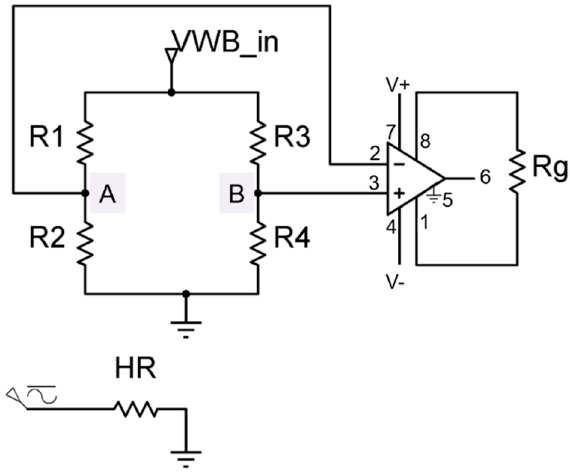
Figure 5. Electronic circuit diagram of the U-shape Wheatstone bridge (WB) as the sensing part in our electro-thermal piezoresistive cantilever that is connected to an instrumentation amplifier.